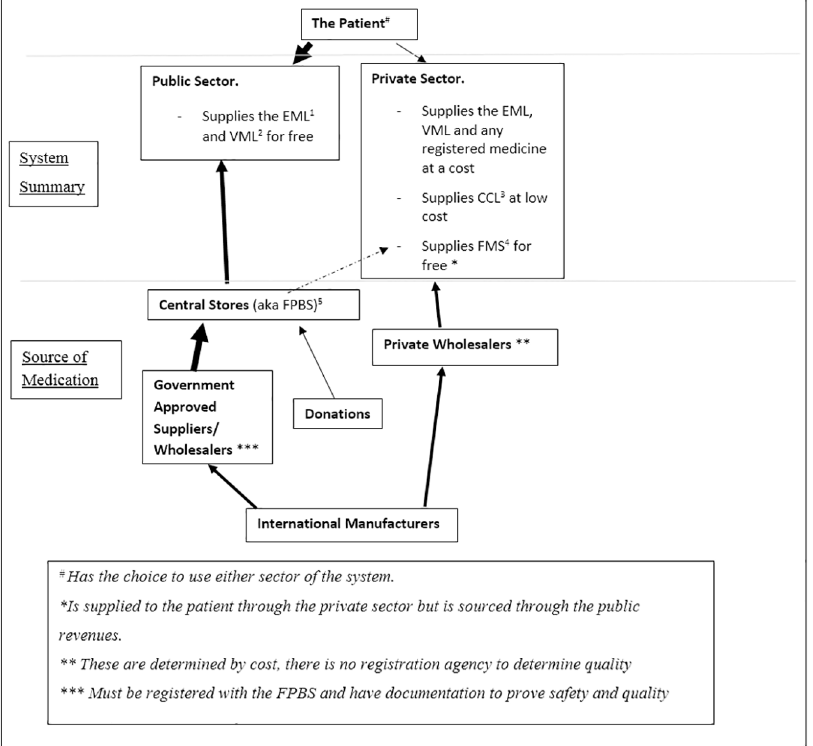
Fig 1. A summation of how patient’s accessmedicines within the Fijian healthcare setting [14]. (The arrows represent movement towards an area, whetherthis be peopleor medicine.The thicker arrows indicate heavier use of this pathway.). Additionalexplanation of the different aspects can be found in Table